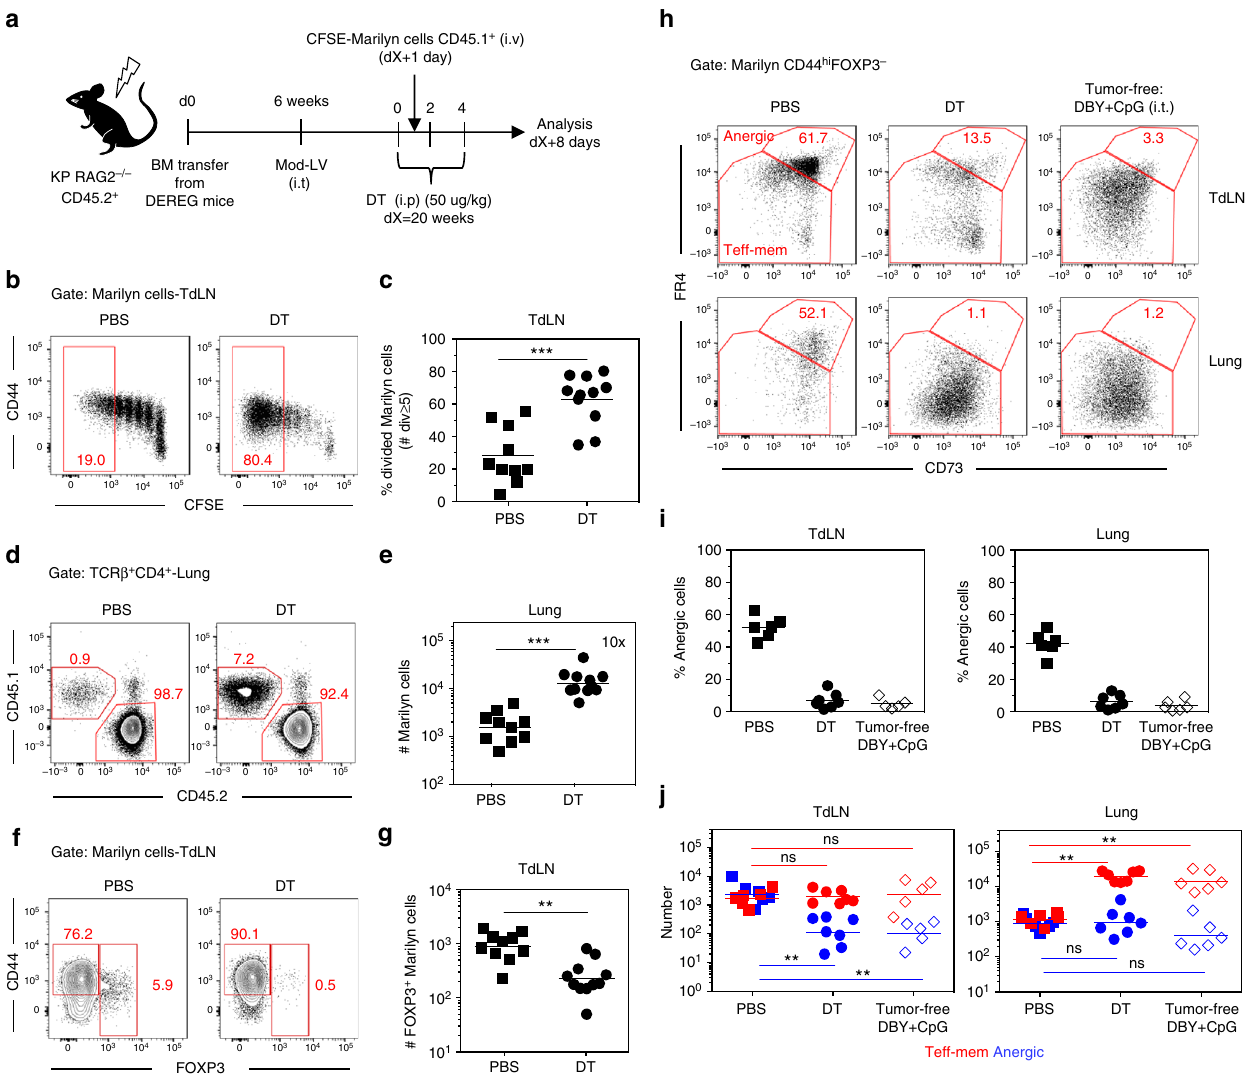
Fig. 8 Depletion of host Tregs inhibits Marilyn T cell conversion into Tregs and restores their effector functions. a Irradiated KP RAG2 -/- mice (5.5 Gy) were reconstituted with bone marrow from DEREG mice. Once the tumors were established, host Tregs were depleted by administration of 3 doses of DT i. p. at 2-day intervals. CFSE-labeled naive Marilyn cells were transferred 1 day after the fi rst dose of DT and the analysis was performed 7 days later. b Pattern of proliferation of Marilyn cells in the TdLN and c quanti fi cation (frequency of ≥ 5 divisions). d Representative plots showing the frequency of Marilyn cells among the CD4 + T cells in the lung and e quanti fi cation (number). f FOXP3 expression by Marilyn cells and g quanti fi cation (number). h Representative expression of CD73 and FR4 by CD44 hi FOXP3 − Marilyn cells and i , j quanti fi cation (frequency and number). Pooled data of two independent experiments. ns: non-signi fi cant, ** p <0.01, *** p <0.001 Mann – Whitney U